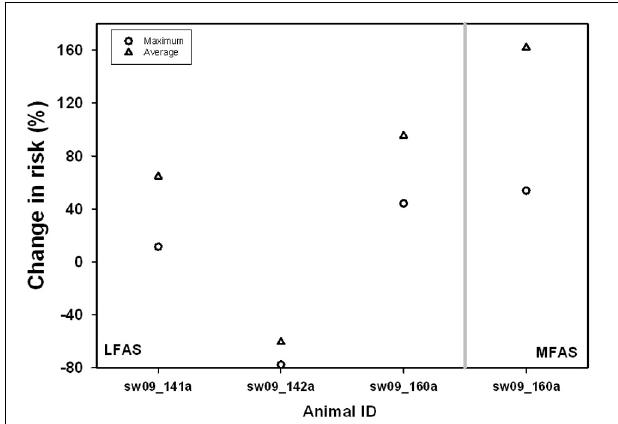
FIGURE 2 | Average ( (cid:2) ) and maximum (o) change in risk − P ] } during 1–2kHz LFAS (left) or 6–7kHz MFAS { risk = [ P venN N 2 ( amb ) 2 (right) sonar exposure compared to control in behaviorally responding sperm whales. Data are modified from Kvadsheim et al. (2012).